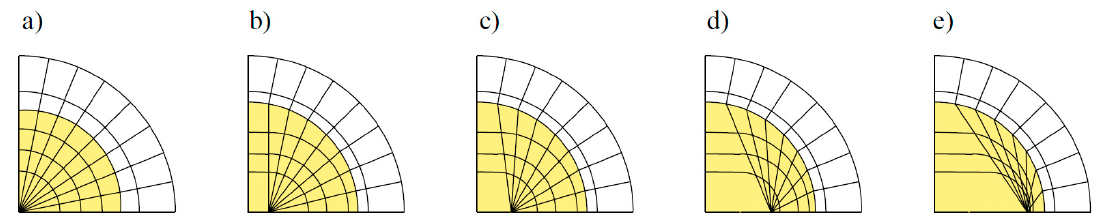
Figure 8. Five degrees (a-e) of mesh non-orthogonality, from an orthogonal mesh to a distorted mesh [48].